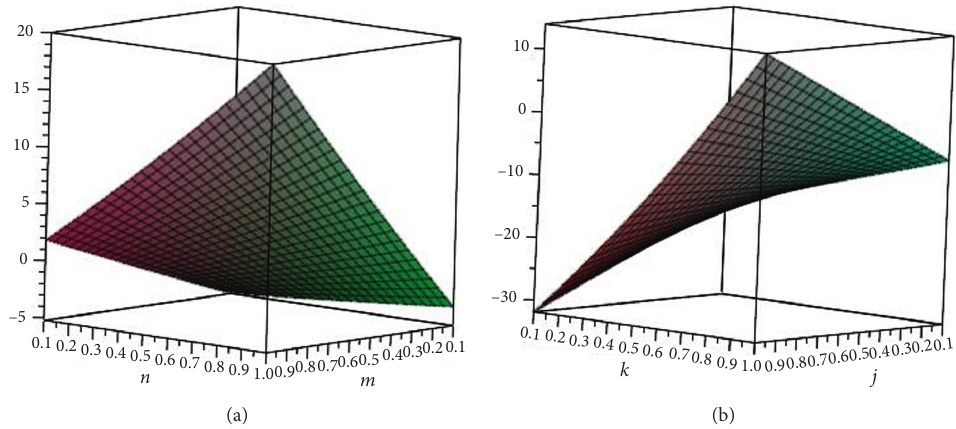
Figure 2: (a) First Zagreb index for j ≤ k . (b) Second Zagreb index for j ≤ k .